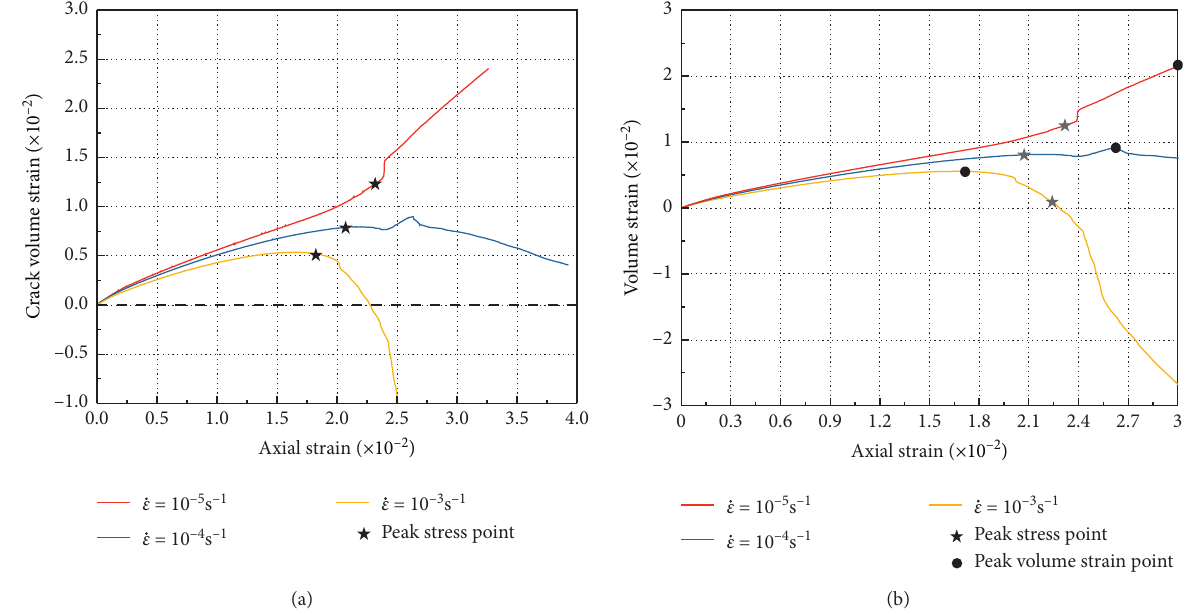
Figure 6: Different methods to determine stress threshold: (a) crack volumetric strain method; (b) volume strain method.